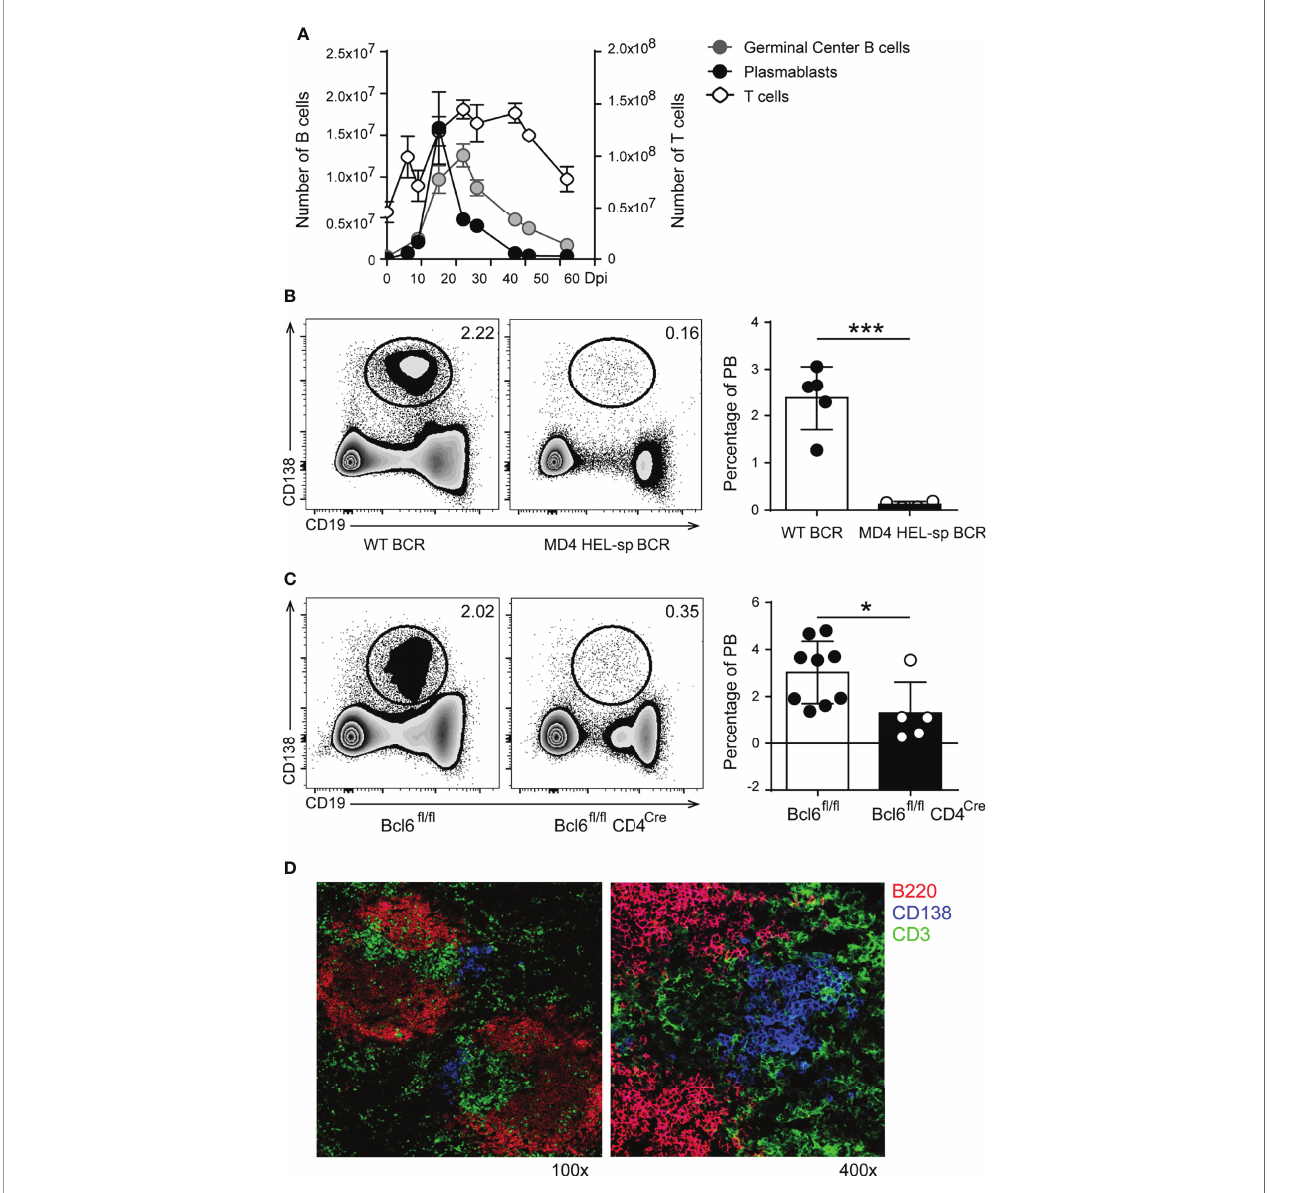
FIGURE 1 | In T. cruzi infection, the plasmablast response peaks before GC reaction, was generated in a BCR speci fi c manner and required Bcl-6 + CD4 + T cell collaboration. (A) Kinetics of plasmablasts (PB, CD19 int B220 low CD138 hi ), Germinal Center (GC) B cells (CD19 + CD3 - CD138 - B220 + CD38 low Bcl6 +) and CD3 + CD4 + T cells number in the spleen of T. cruzi infected mice. (B) Representative fl ow cytometry plots and statistical analysis of the percentage of splenic PB (CD138 + CD19 int / low ) from WT (WT BCR, n = 5) and MD4 (HEL-sp BCR, n = 8) mice at 14 Dpi with T. cruzi (***p<0.001, two tailed t Test). (C) Representative fl ow cytometry plots and statistical analysis of the percentage of splenic PB from Cre negative littermates Bcl6 fl / fl (n = 9) and Bcl6 fl / fl CD4 Cre (Bcl-6 neg CD4+ T cells, n = 5) mice at 14 Dpi with T. cruzi. (*p<0.05, two tailed t Test) (D) Representative Immuno fl uorescence of spleen sections (7um) from T. cruzi-infected C57BL/6 mice obtained at 14 Dpi, stained with anti-B220 (red), anti-CD3 (green) and anti-CD138 (blue). Magni fi cation: x100 (left) and x400 (right) (n = 9). Results shown in (A, D) are representative of fi ve independent experiments. Data in (B, C) are representative of two independent